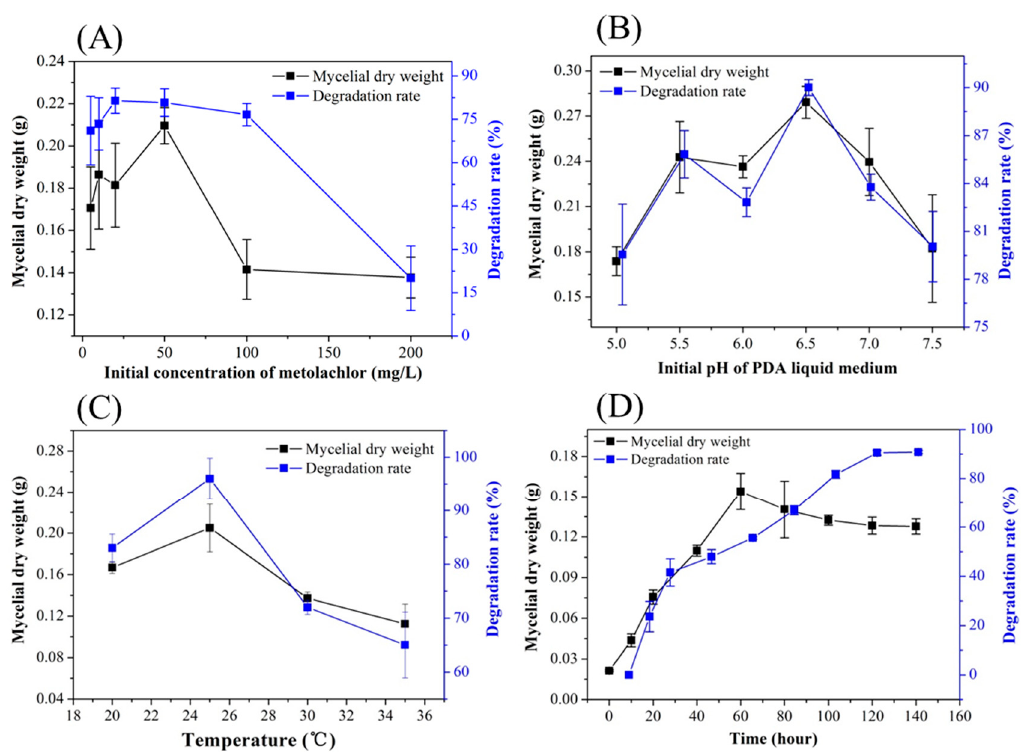
Figure 3. Effects of initial concentration of metolachlor ( A ), initial pH ( B ), temperature ( C ), and time of incubation ( D ) on metolachlor degradation and growth of strain MET-F-1.